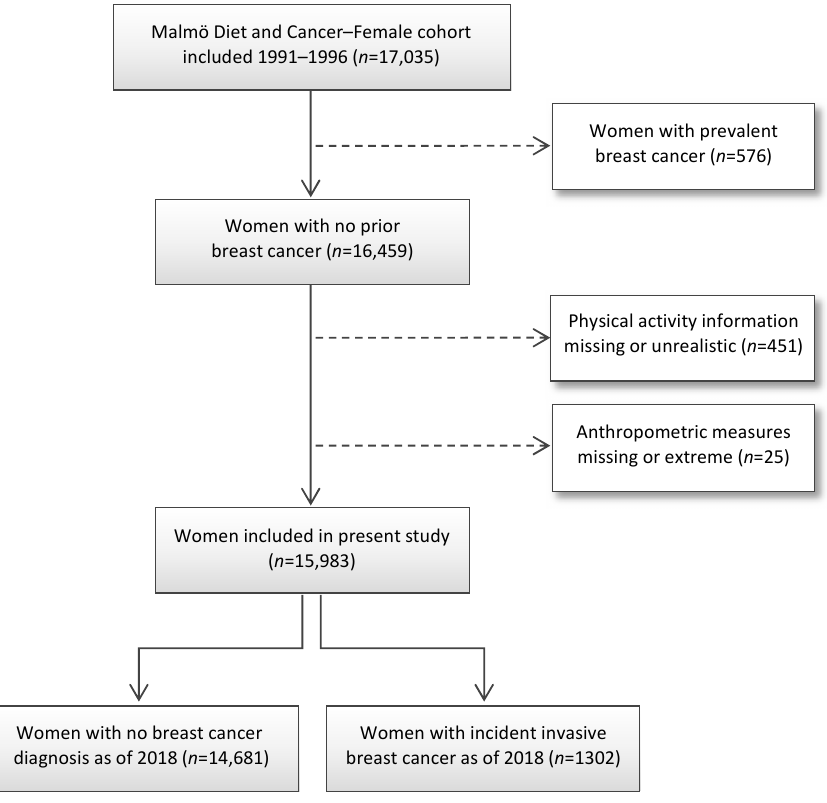
Figure 1. CONSORT flow diagram of the study population.